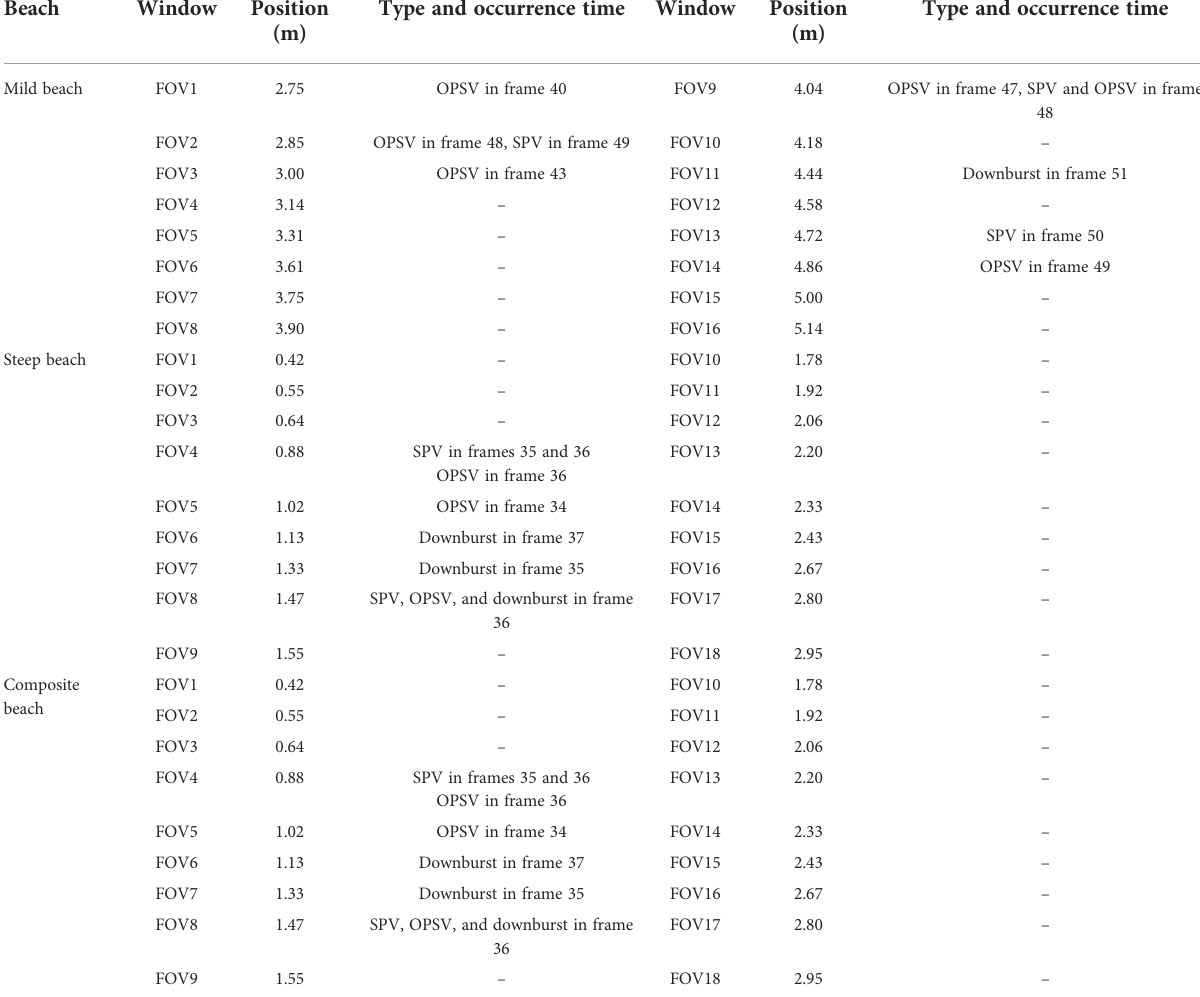
TABLE 3 The characteristics of the vortex structure.